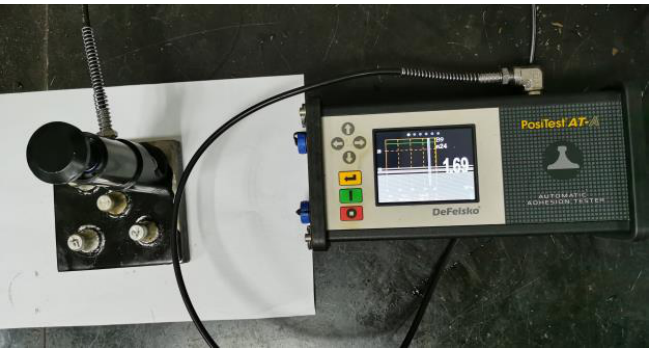
Figure 2. Portable automatic adhesion tester and testing configuration.